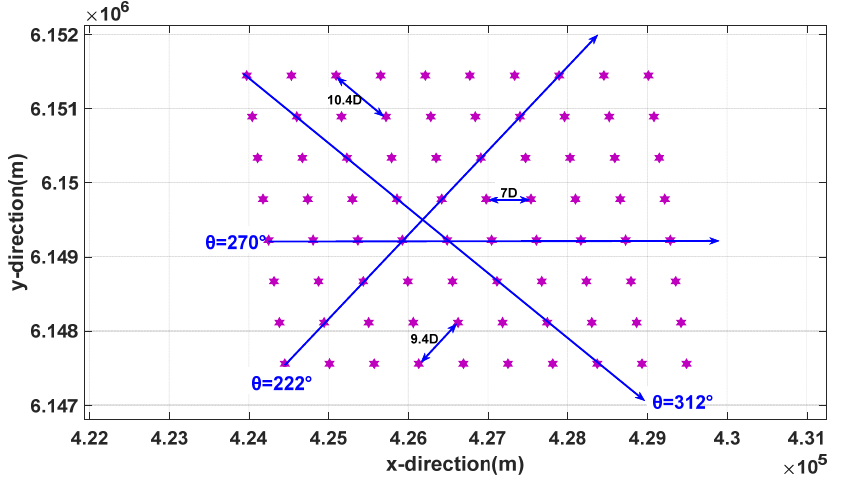
Figure 4. Layout of the Horns Rev wind farm.